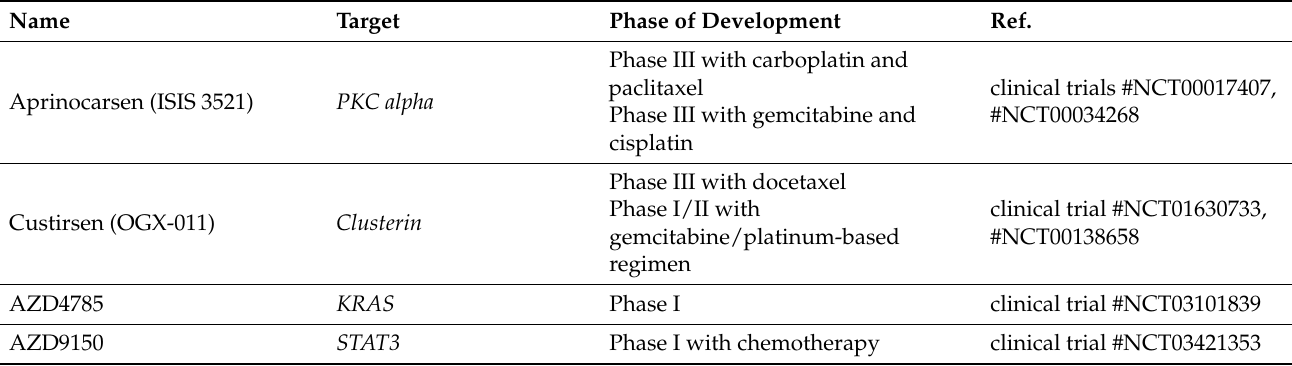
Table 1. ASO applications in